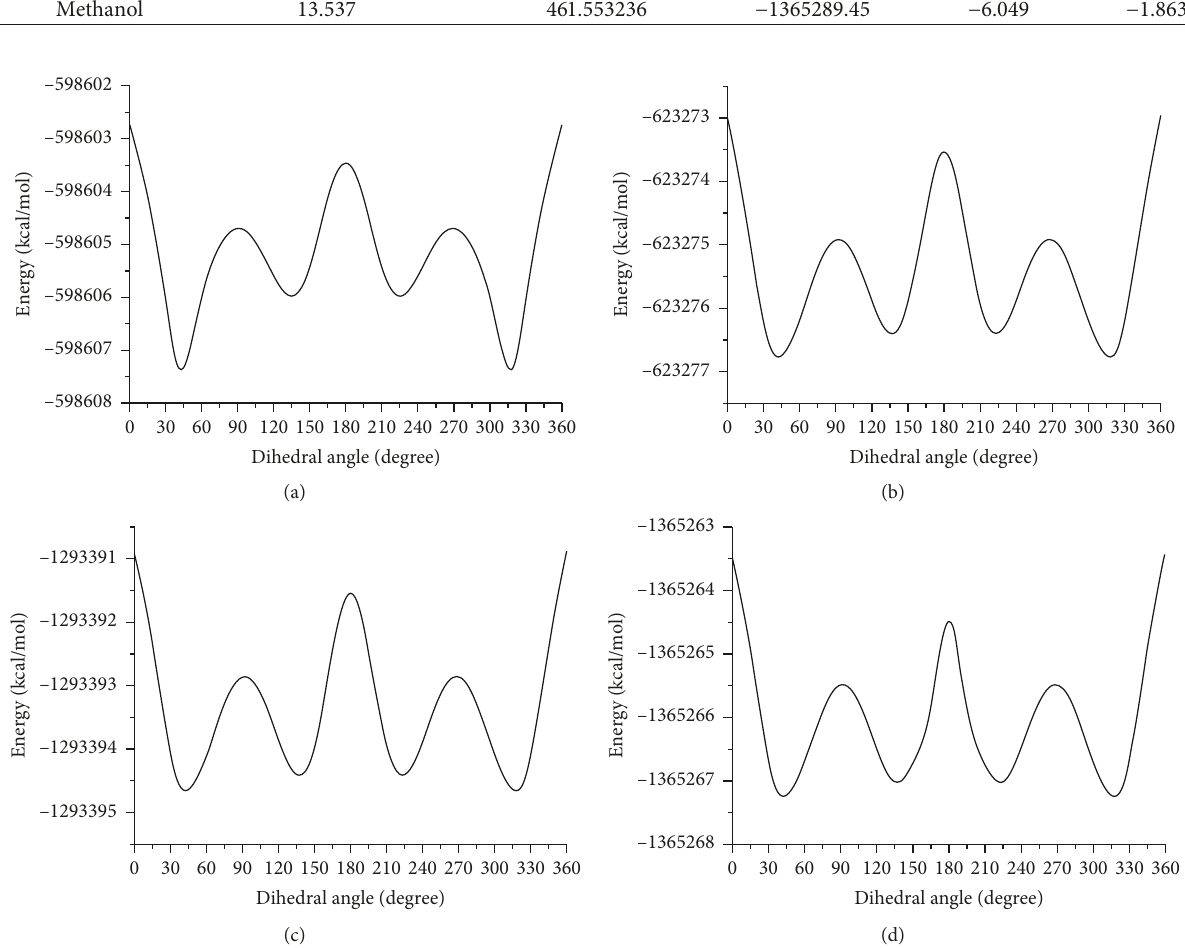
Figure 3: Potential energy curves versus torsional angle of studied structures 1–4 in gas medium. (a) Compound 1 . (b) Compound 2 . (c) Compound 3 . (d) Compound 4